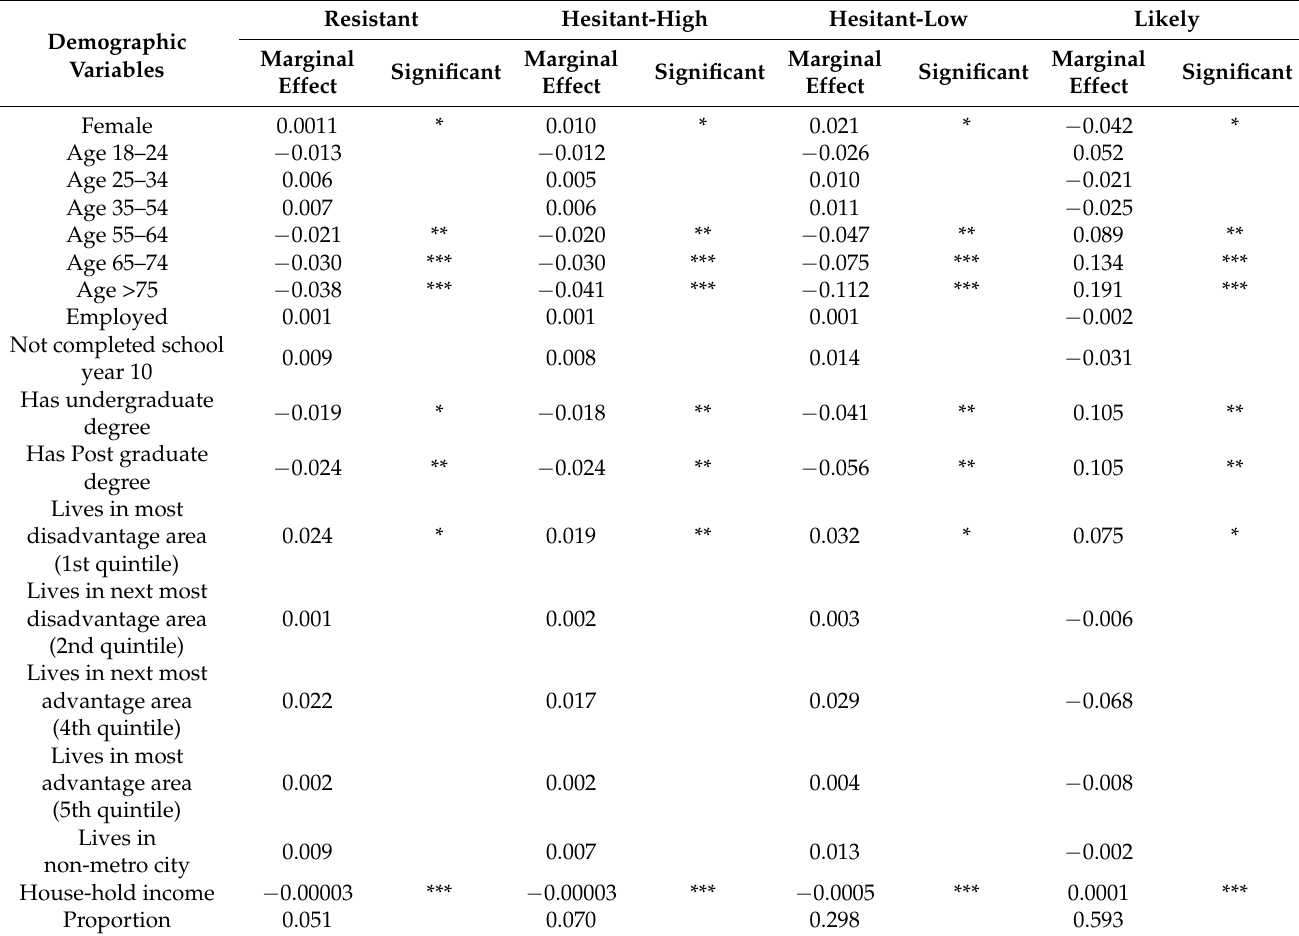
Table 1. Minimetric poll survey chart demonstrating statistically significant